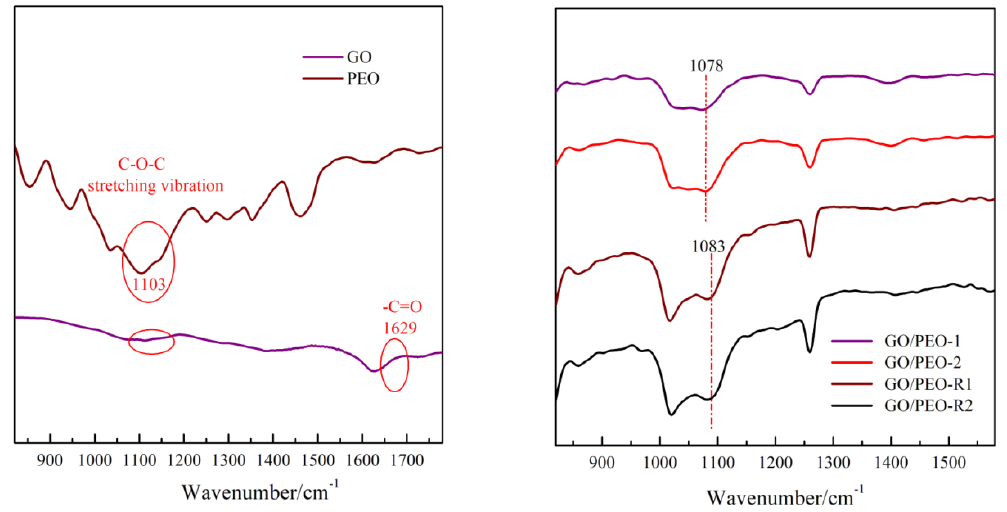
Figure 3. ( a ) FTIR spectra of pristine GO and PEO and ( b ) FTIR spectra of GO/PEO-1 and GO/PEO-2 with and without reduction.